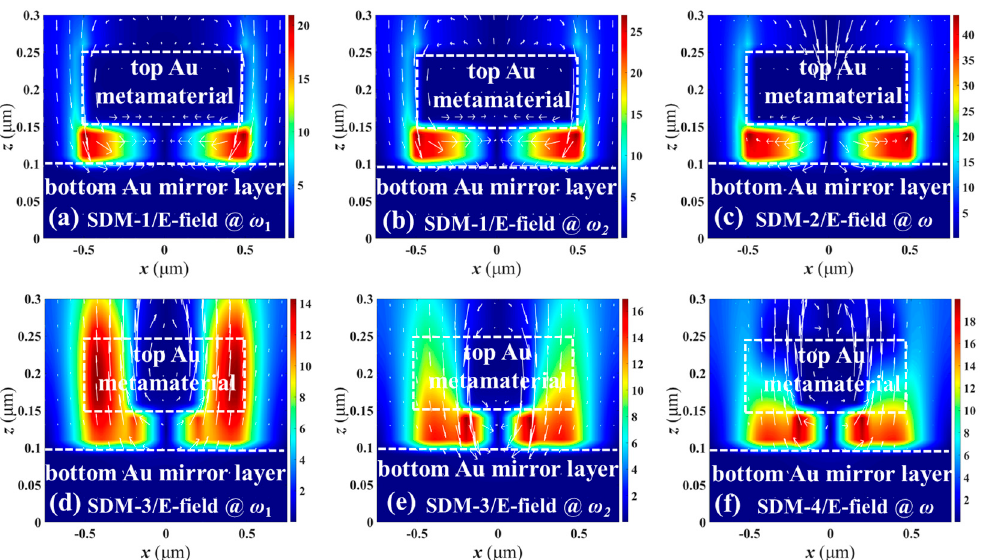
Figure 7. E-field distributions of SDM-1 monitored at ( a ) ω 1 and ( b ) ω 2 resonances, SDM-2 monitored at ( c ) ω resonance, SDM-3 monitored at ( d ) ω 1 and ( e ) ω 2 resonances, and SDM-4 monitored at ( f ) ω resonance, respectively.